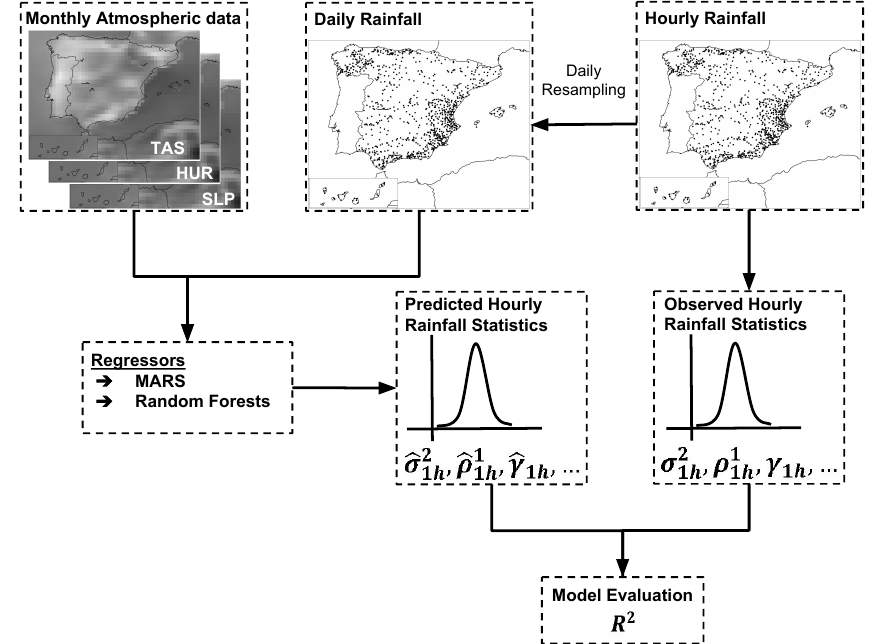
Figure 2. Scheme of the methodology. First, hourly rainfall data are aggregated into daily data. Second, supradaily and subdaily rainfall statistics are estimated. Third, monthly atmospheric series from reanalysis data over the period of observation of the corresponding hourly rainfall series are extracted in each gauge location. Then, monthly statistics (mean and variance) are estimated from atmospheric predictors. Daily and supradaily rainfall statistics together with monthly atmospheric statistics and elevation are used as a predictors. The regressor is trained to fit the observed statistics of hourly rainfall. SLP, sea-level pressure; MARS, multivariate adaptive regression